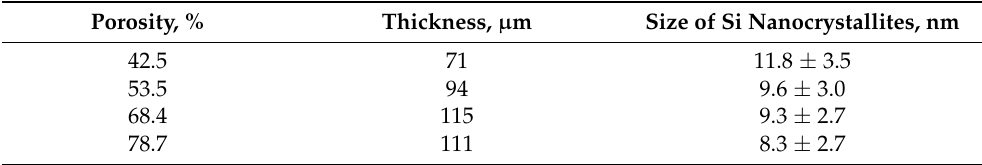
Table 1. Porosity-dependent size distribution of Si nanocrystallites.